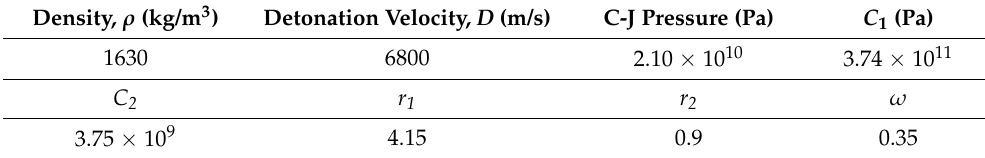
Table 1. Parameters of TNT in the JWL equation of state.